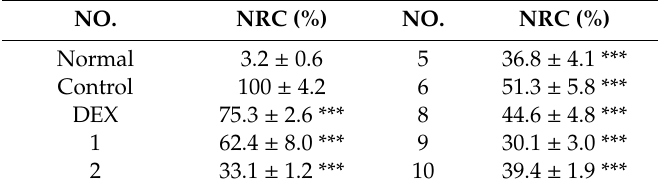
Table 12. Inhibitory e ff ects of 1 , 2 , 5 , 6 , and 8 – 10 on NO production in RAW 264.7 cells.